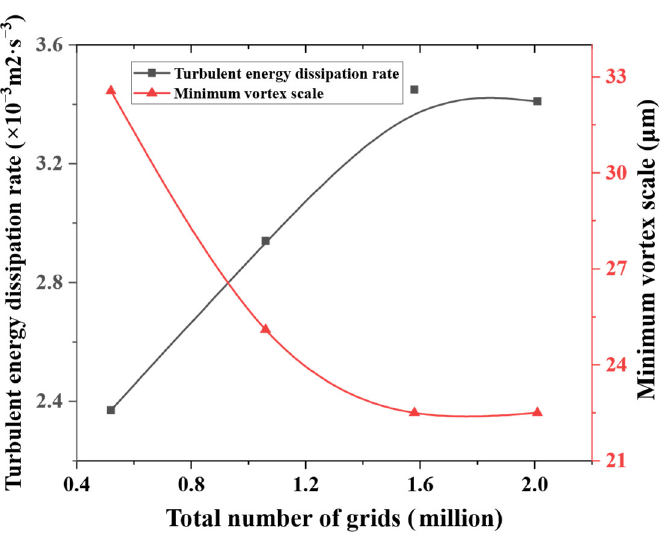
Figure 4. Grid independence verification.